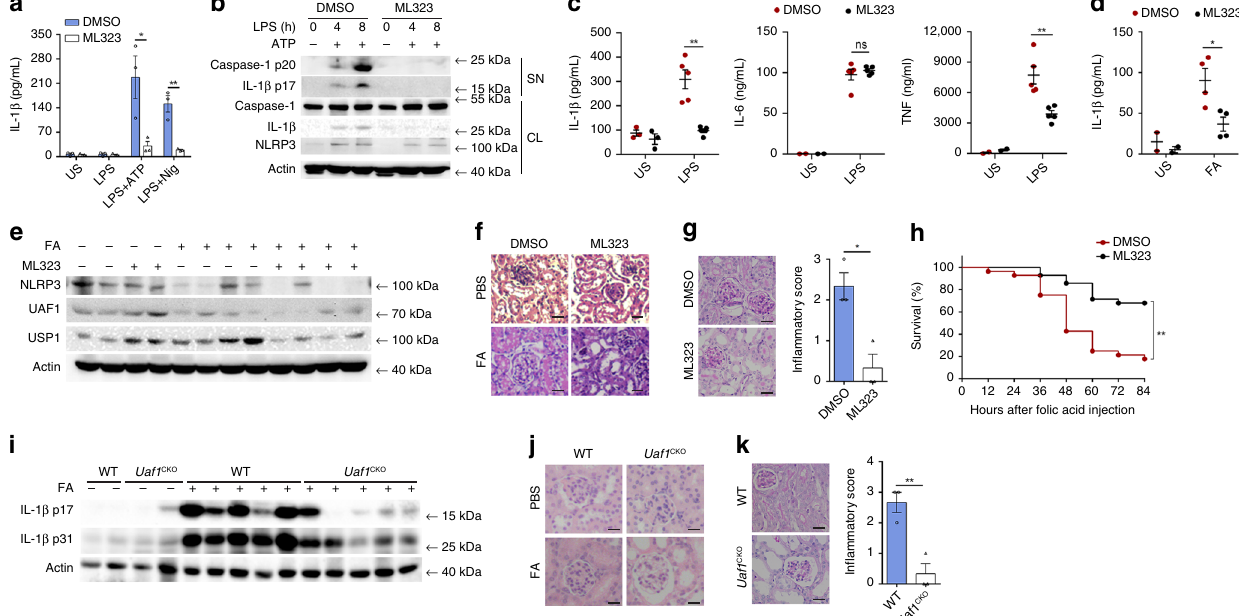
Fig. 7 ML323 and Uaf1 de fi ciency ameliorate NLRP3-dependent in fl ammation. a ELISA analysis of IL-1 β secretion in mouse peritoneal macrophages pretreated with DMSO or ML323 for 4 h, followed by LPS stimulation for 8 h and treatment with ATP or Nig for the last 40 min (mean ± SEM, two-tailed t - test ML323 vs. DMSO, * P = 0.0347, ** P = 0.0049 in sequence; n = 3 independent experiments). b Western blot analysis of caspase-1 and IL-1 β cleavage in mouse peritoneal macrophages pretreated with DMSO or ML323 for 4 h, followed by LPS stimulation for the indicated time periods and treatment with ATP for the last 40 min. c ELISA analysis of serum levels of IL-1 β , IL-6, and TNF from C57BL/6 mice, initially i.p. injected with DMSO or ML323 for 4 h and later with LPS for 90 min (mean ± SEM, two-tailed t-test ML323 vs. DMSO, left panel: ** P = 0.0007, middle panel: ns = 0.4847, right panel: ** P = 0.0034; n = 5 independent experiments). d ELISA analysis of serum levels of IL-1 β in C57BL/6 mice i.p. injected with DMSO or ML323 for 4 h and then i.p. injected with folic acid (FA) for 12 h (mean ± SEM, two-tailed t-test ML323 vs. DMSO, * P = 0.0193; n = 4 independent experiments). e – g C57BL/6 mice were i.p. injected with DMSO or ML323 for 4 h and then i.p. injected with folic acid (FA) for 36 h. Western blot analysis of NLRP3 expression in kidney samples ( e ), H&E staining of kidney tissue sections ( f ), PAS staining of kidney tissue sections and renal in fl ammation was scored based upon PAS staining ( g ) Scale bar, 20 µ m (mean ± SEM, two-tailed t -test ML323 vs. DMSO, * P = 0.0132; n = 3 independent experiments). h Survival of the C57BL/6 mice i.p. injected with DMSO or ML323 for 4 h and then with FA (mean± SEM, log rank test [Mantel-Cox] ML323 vs. DMSO, ** P < 0.0001; n = 28 independent experiments). i – k WT or Uaf1 CKO mice were i.p. injected with FA for 36 h. Western blot analysis of IL-1 β p17 and p31 in kidney samples ( i ), H&E staining of kidney tissue sections ( j ), PAS staining of kidney tissue sections and renal in fl ammation was scored based upon PAS staining ( k ) (mean ± SEM, two-tailed t -test Uaf1 CKO vs. WT, ** P = 0.0078; n = 3 indepe n dent experiments). US, unstimulated; SN, supernatants; CL, cell lysates. Similar results were obtained from three independent